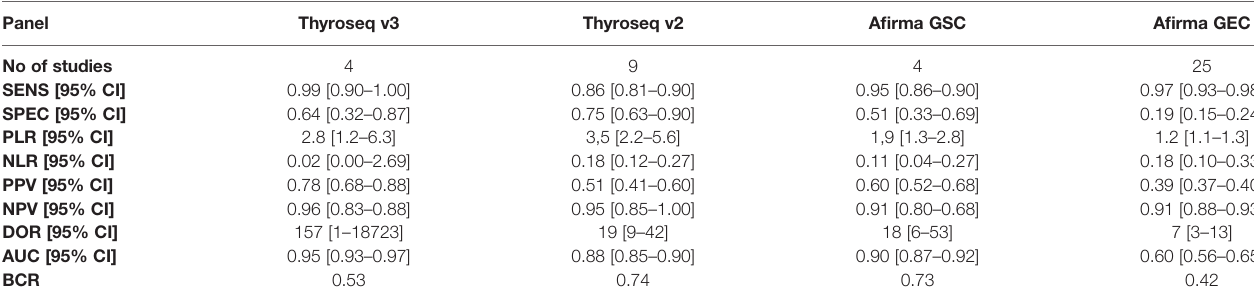
TABLE 2 | Synthesis of the molecular tests ’ diagnostic performance. Panel Thyroseq v3 Thyroseq v2 A fi rma GSC A fi rma GEC No of studies